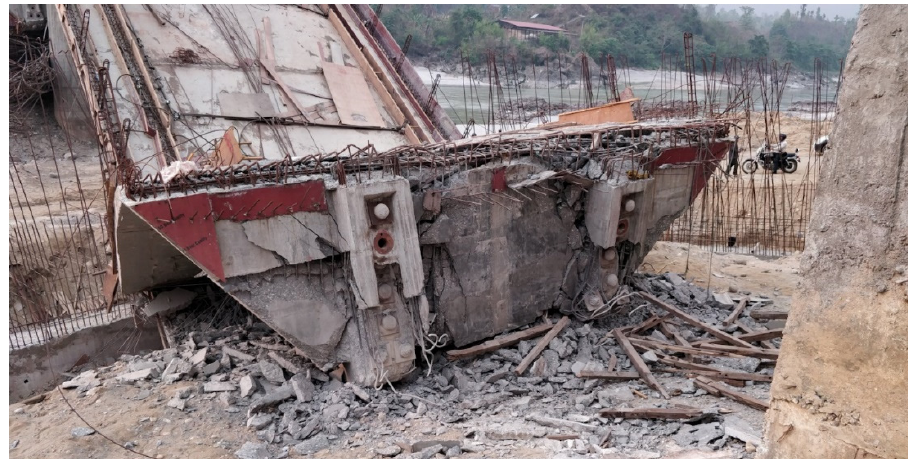
Figure 7. Horizontal shear failure at construction-joint level as the lower part of the beam that included four prestressing ducts slid inwards.